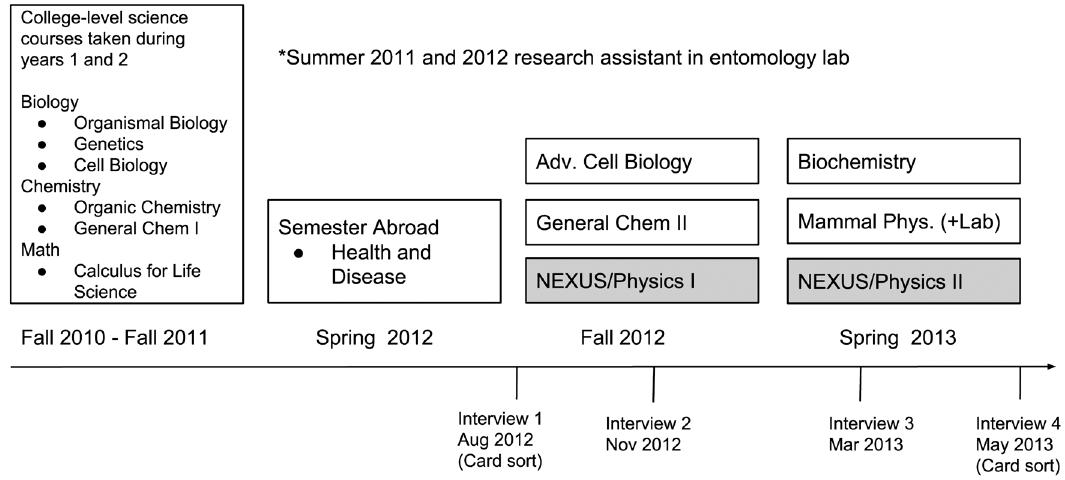
FIG. 2. Science and mathematics courses that Phillip took prior to and concurrent with